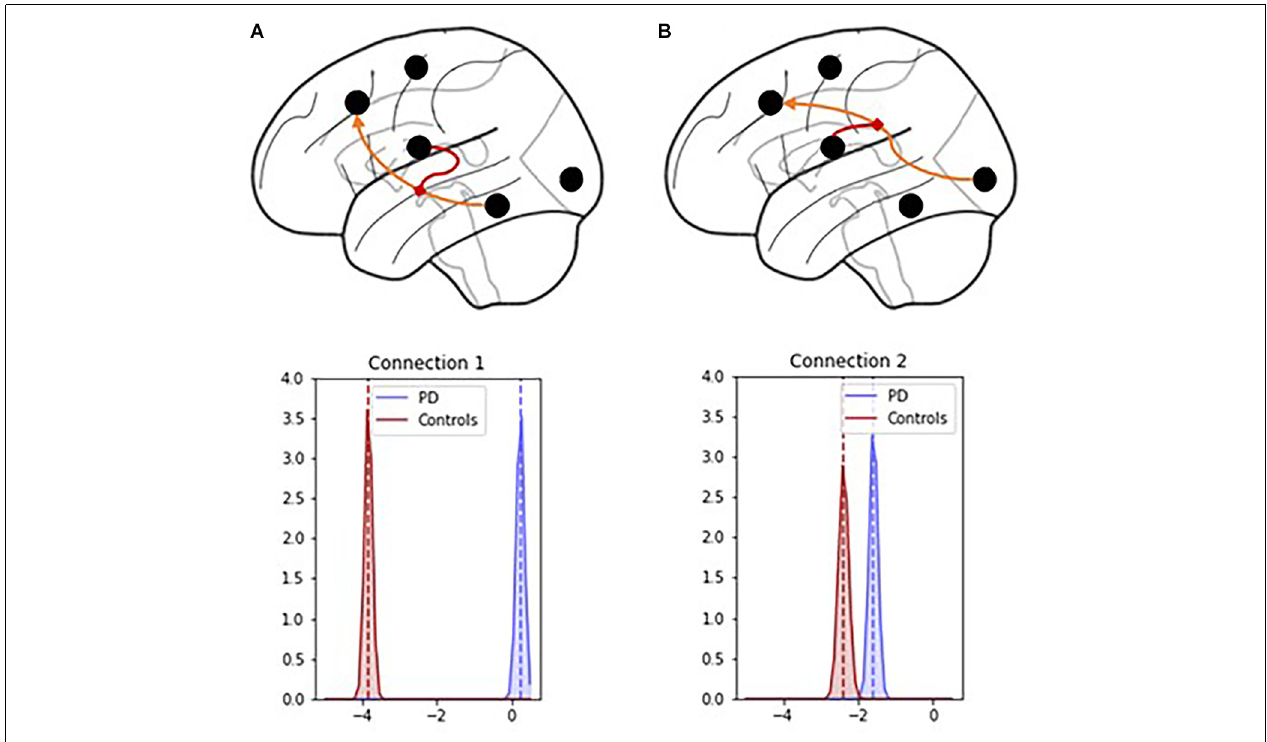
FIGURE 6 | Connection 1 and 2 parameters and their associated posterior probability distributions. (A) In Connection 1, the basal ganglia modulate the signals flowing from the hippocampus and temporal lobe to the prefrontal cortex. (B) In Connection 2, the basal ganglia modulate the signals flowing from the visual, auditory, and sensory cortices to the prefrontal cortex.